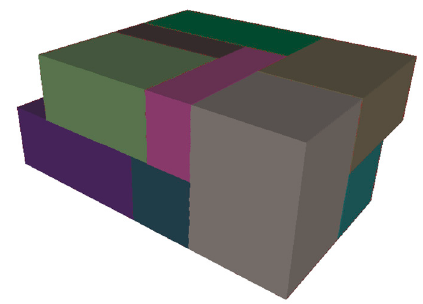
Figure 5. Solid geometries created from the predefined surfaces.